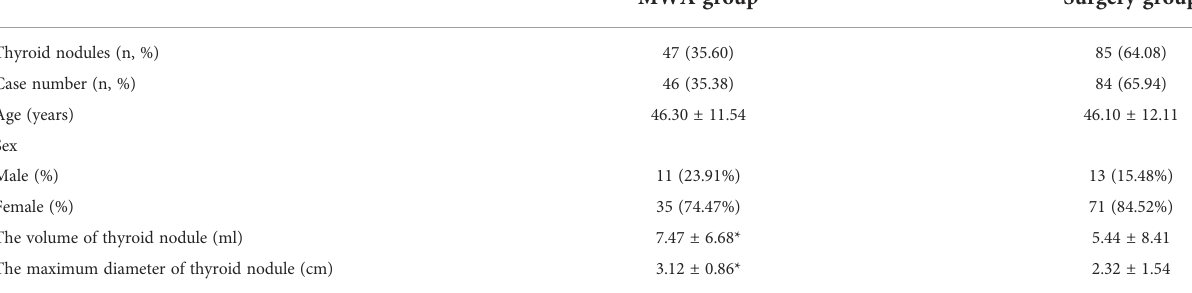
TABLE 1 Baseline characteristics of patients with Bethesda category IV thyroid nodules (n =